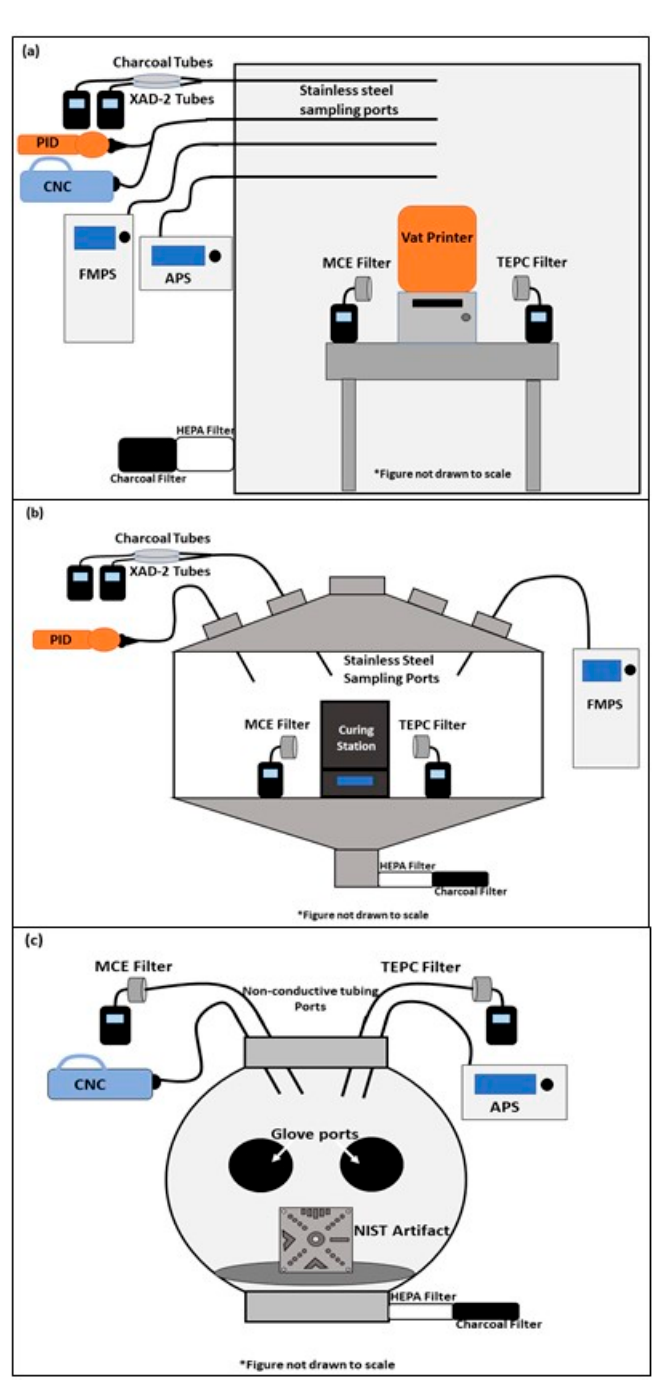
Figure 1. ( a ) 12.85 m 3 chamber utilized for the pouring, printing, recovery, and isopropyl alcohol rinsing, soaking, and drying tasks; ( b ) 0.5 m 3 chamber used for the curing task; ( c ) 0.065 m 3 glove box used for the sanding task. Sampling ports leading into each chamber connected to specific real- time instruments and sampling media tailored for each task. APS = aerodynamic particle sizer; CNC = condensation nuclei counter; FMPS = fast mobility particle sizer; HEPA = high efficiency particu- late air; PID = photoionization detector; MCE = mixed cellulose ester; TEPC = track-etched polycar-